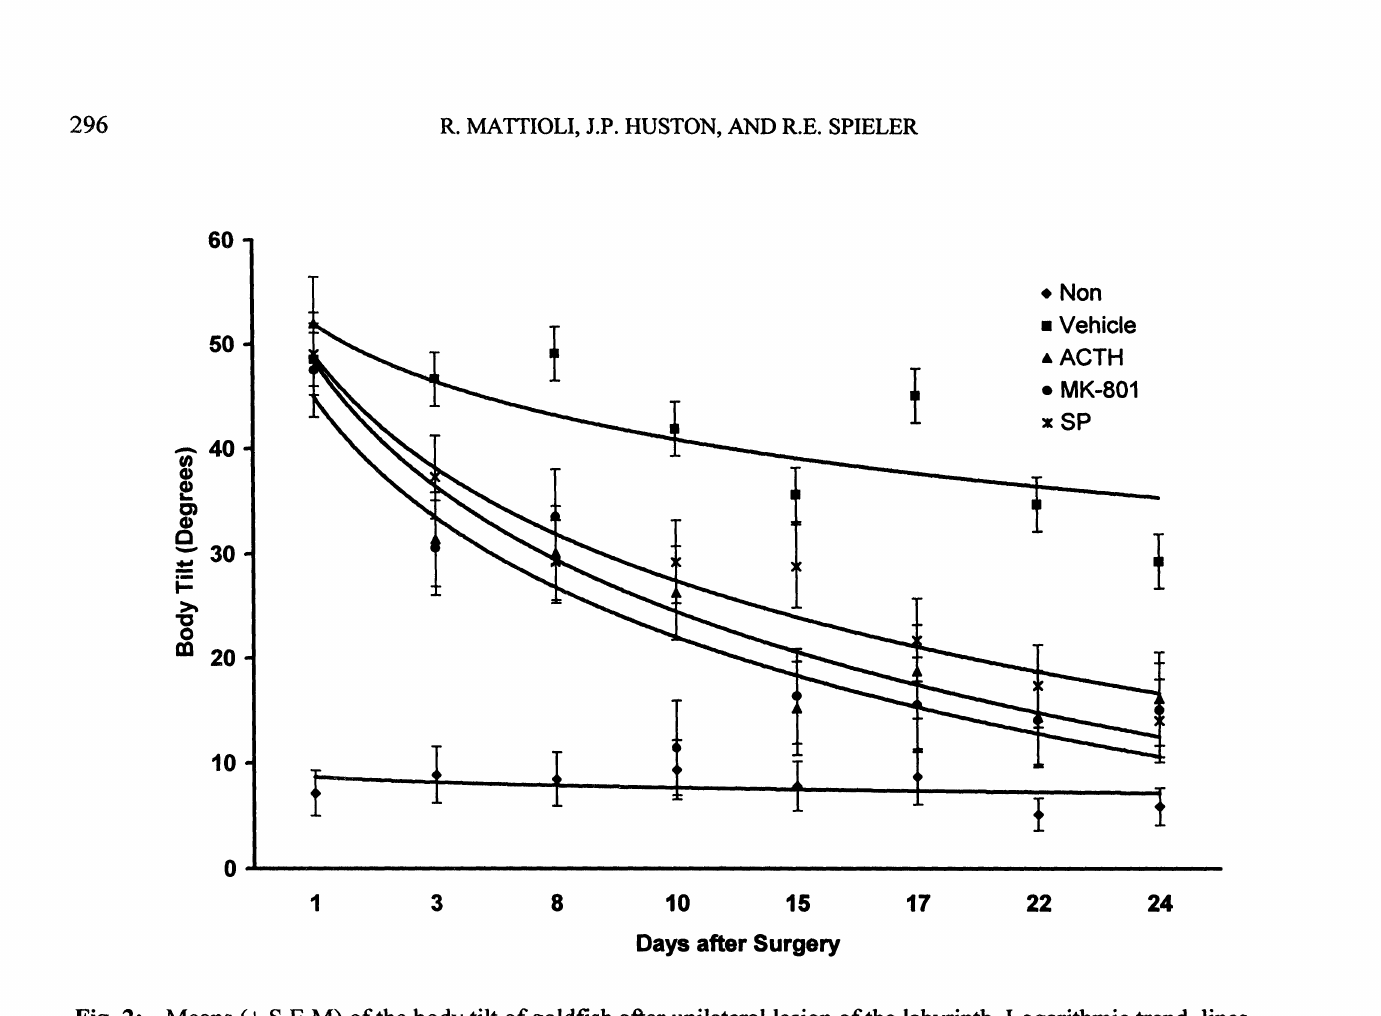
Days after Surgery Means (+ S.E.M) ofthe body tilt of goldfish after unilateral lesion of the labyrinth. Logarithmic trend-lines were added for visualization purposes only. The trend-lines, from top to bottom represent the best fitting curve for the results of the NON, VEH, ACTH, MK and SP groups